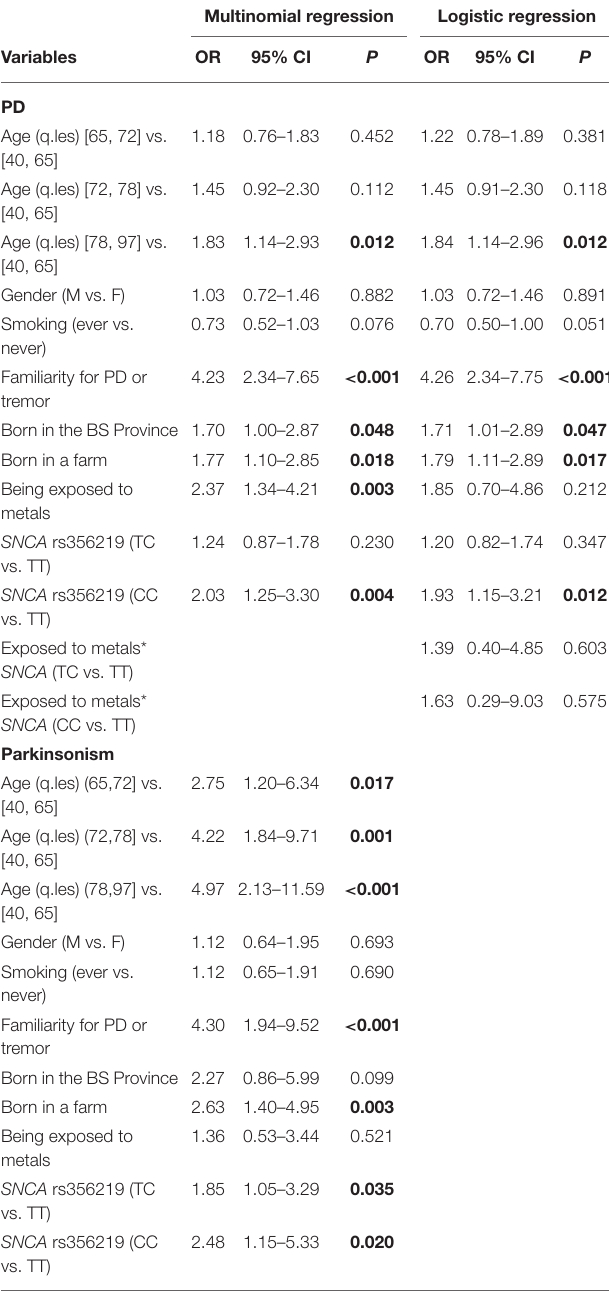
TABLE 4 | Results of multinomial and logistic regression analysis to test for the association between risk factors (age, gender, smoking status, PD or tremor familiarity, SNCA rs356219, being born in a farm, being exposed to metals and being born in the province of Brescia) and PD and